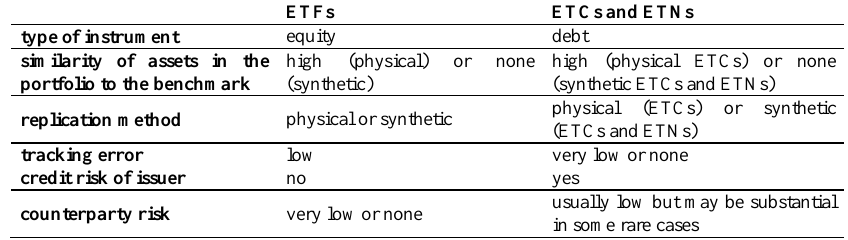
Table 1. Types of exchange-traded products: comparison of key features